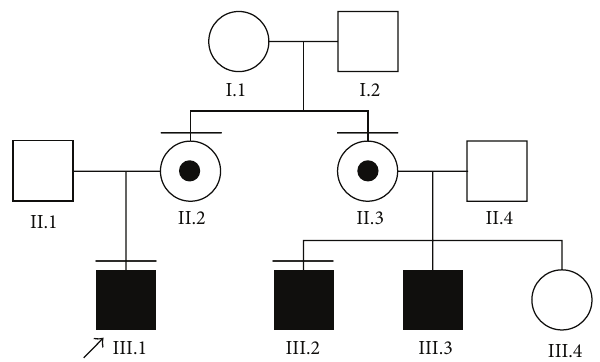
Figure 2: Pedigree of the family. Horizontal bars above the symbols represent availability for genetic